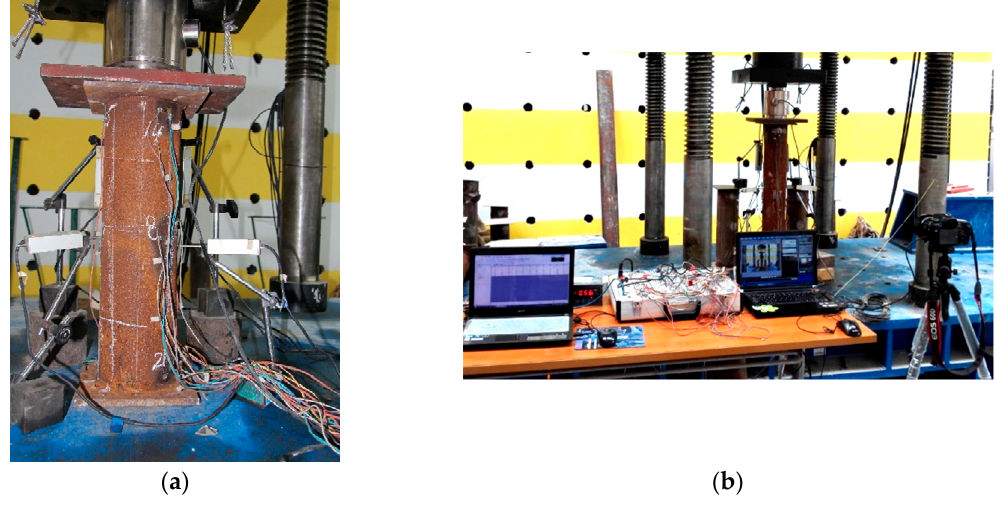
Figure 3. Photo of test setup and data acquisition devices. ( a ) The specimen; ( b ) the data acquisition device.